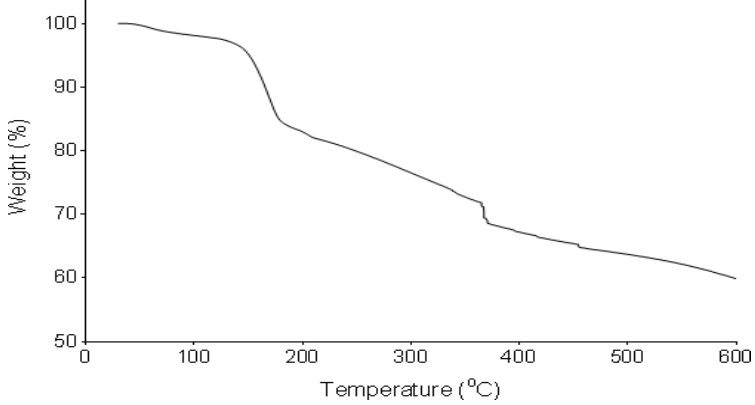
Figure 3. Pyrolysis profile of the bioflocculant from B. subtilis CSM5.